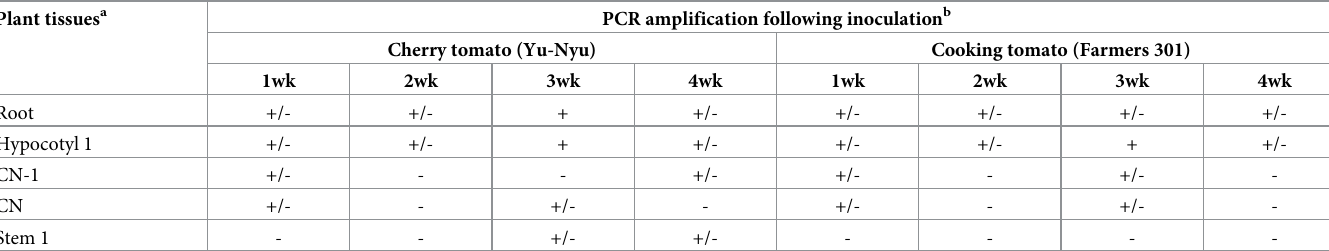
Table 3. Distribution of HOFo isolate MCC2074 in tomato plant tissues based on specific primers Primer 5/ST33-R following soil drench inoculation. Plant tissues